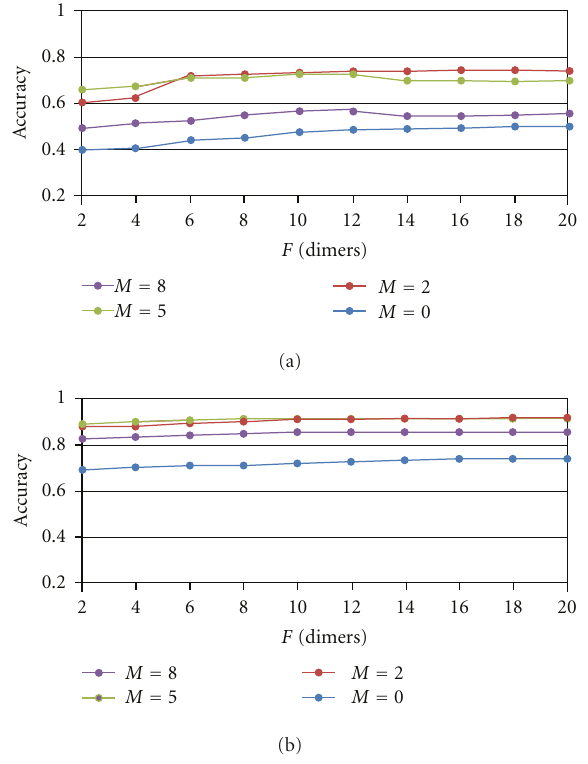
Figure 5: F-view. (a) Full-exon level accuracy for C. elegans with 5-fold cross-validation. (b) Base level accuracy for C. elegans with 5-fold cross-validation.